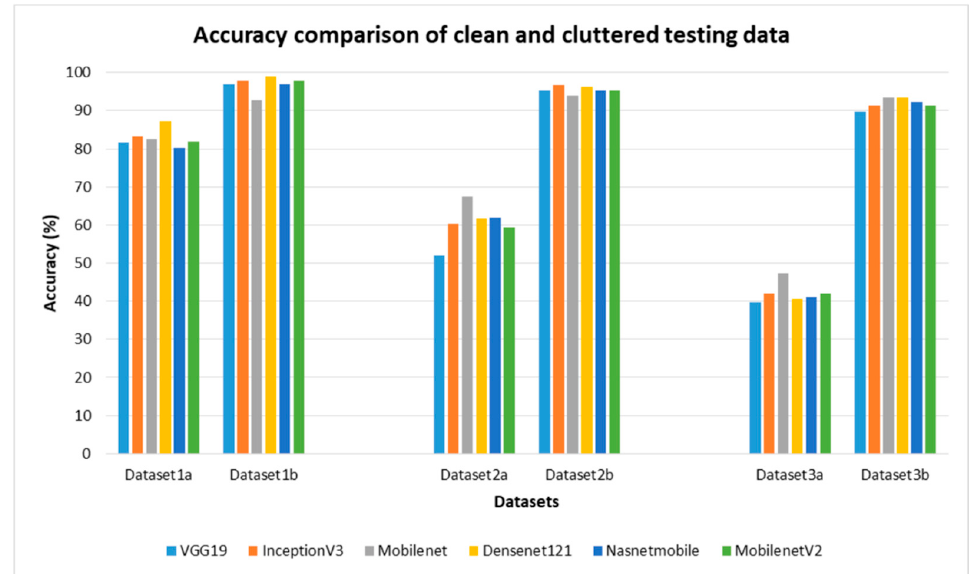
Figure 10. Testing accuracy achieved by various pre-trained fine-tuned CNN models on a different number of classes of datasets. Dataset1a, dataset2a, and dataset3a contain testing images taken in true field conditions. Dataset1b, dataset2b, and dataset3b contain the test images cleaned with the proposed background removal algorithm.